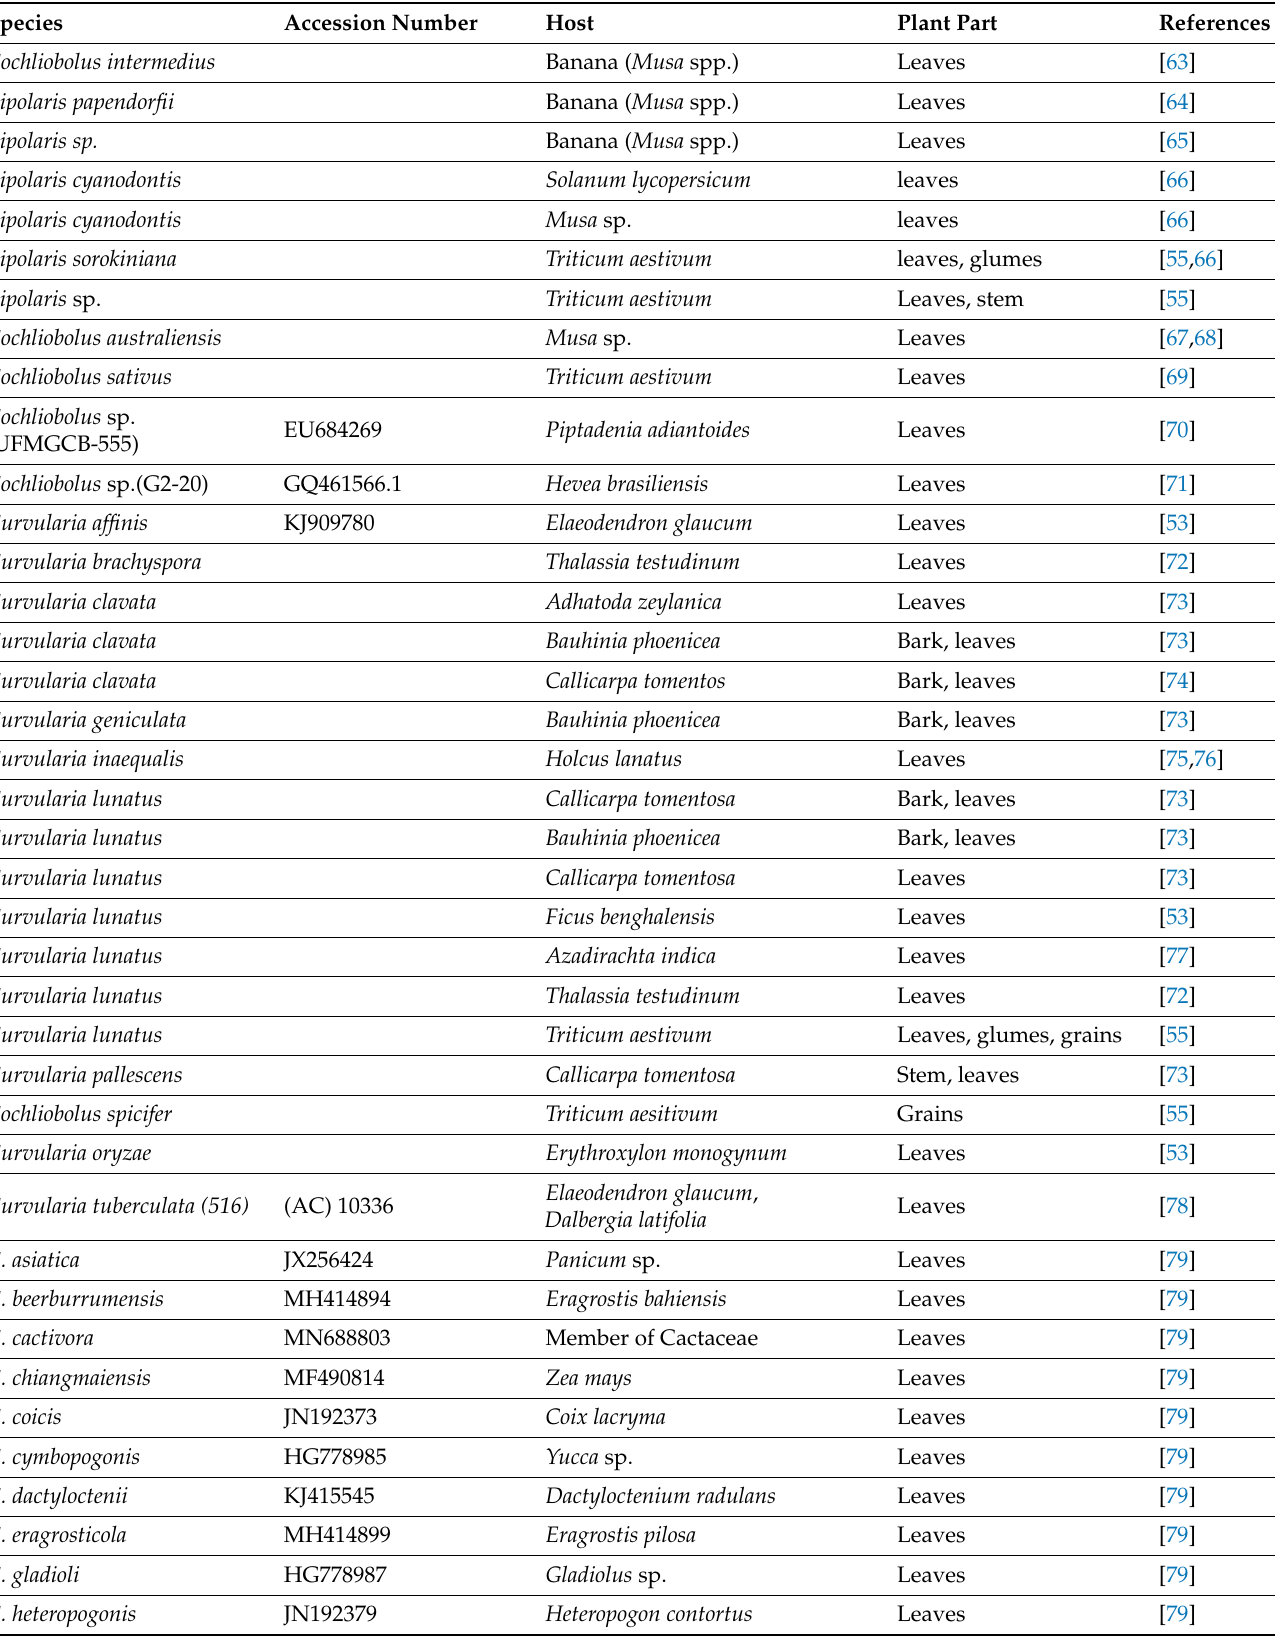
Table 1. Cochliobolus , Curvularia, and Bipolaris species as